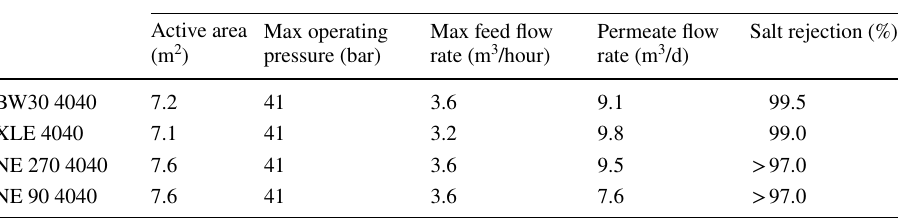
Table 1 Characteristics of membrane’